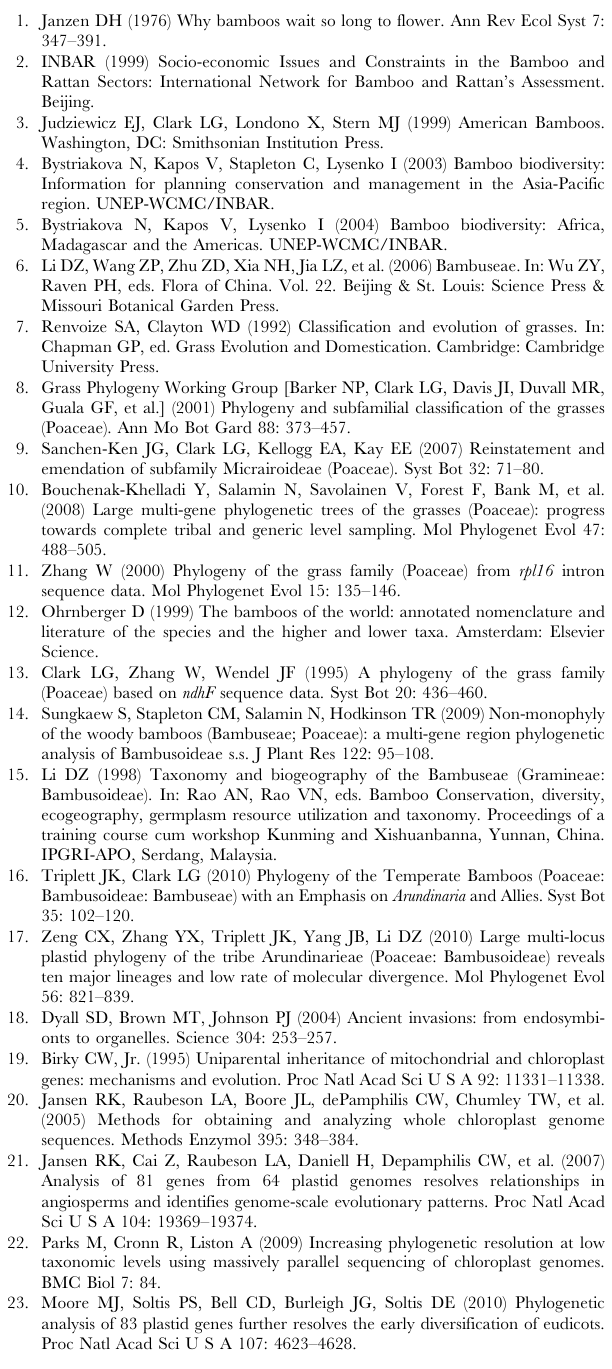
Table S4 The locations and sequences of 12 small inversions in eight woody bamboo chloroplast genomes. Table S5 Indels in exons of 21 genes in the grass chloroplast genomes. Table S6 Summary statistics for noncoding regions in the chloroplast genomes of